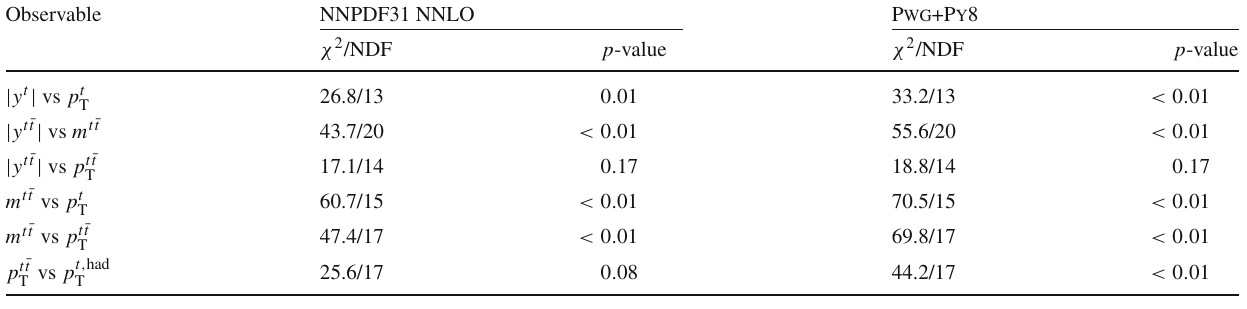
diction a χ 2 and a p -value are calculated using the covariance matrix of the measured spectrum. The NDF is equal to the number of bins in the distribution